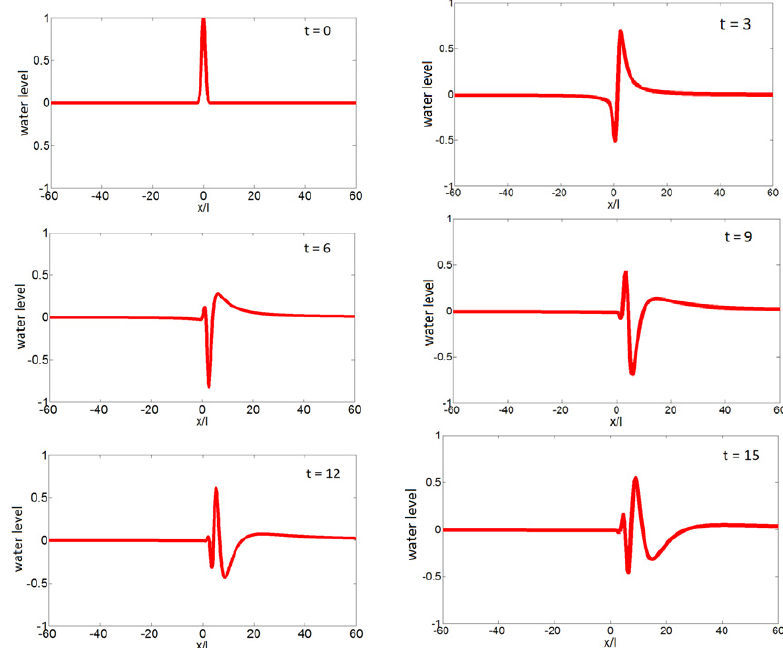
Fig. 3. Evolution of the pulse at short